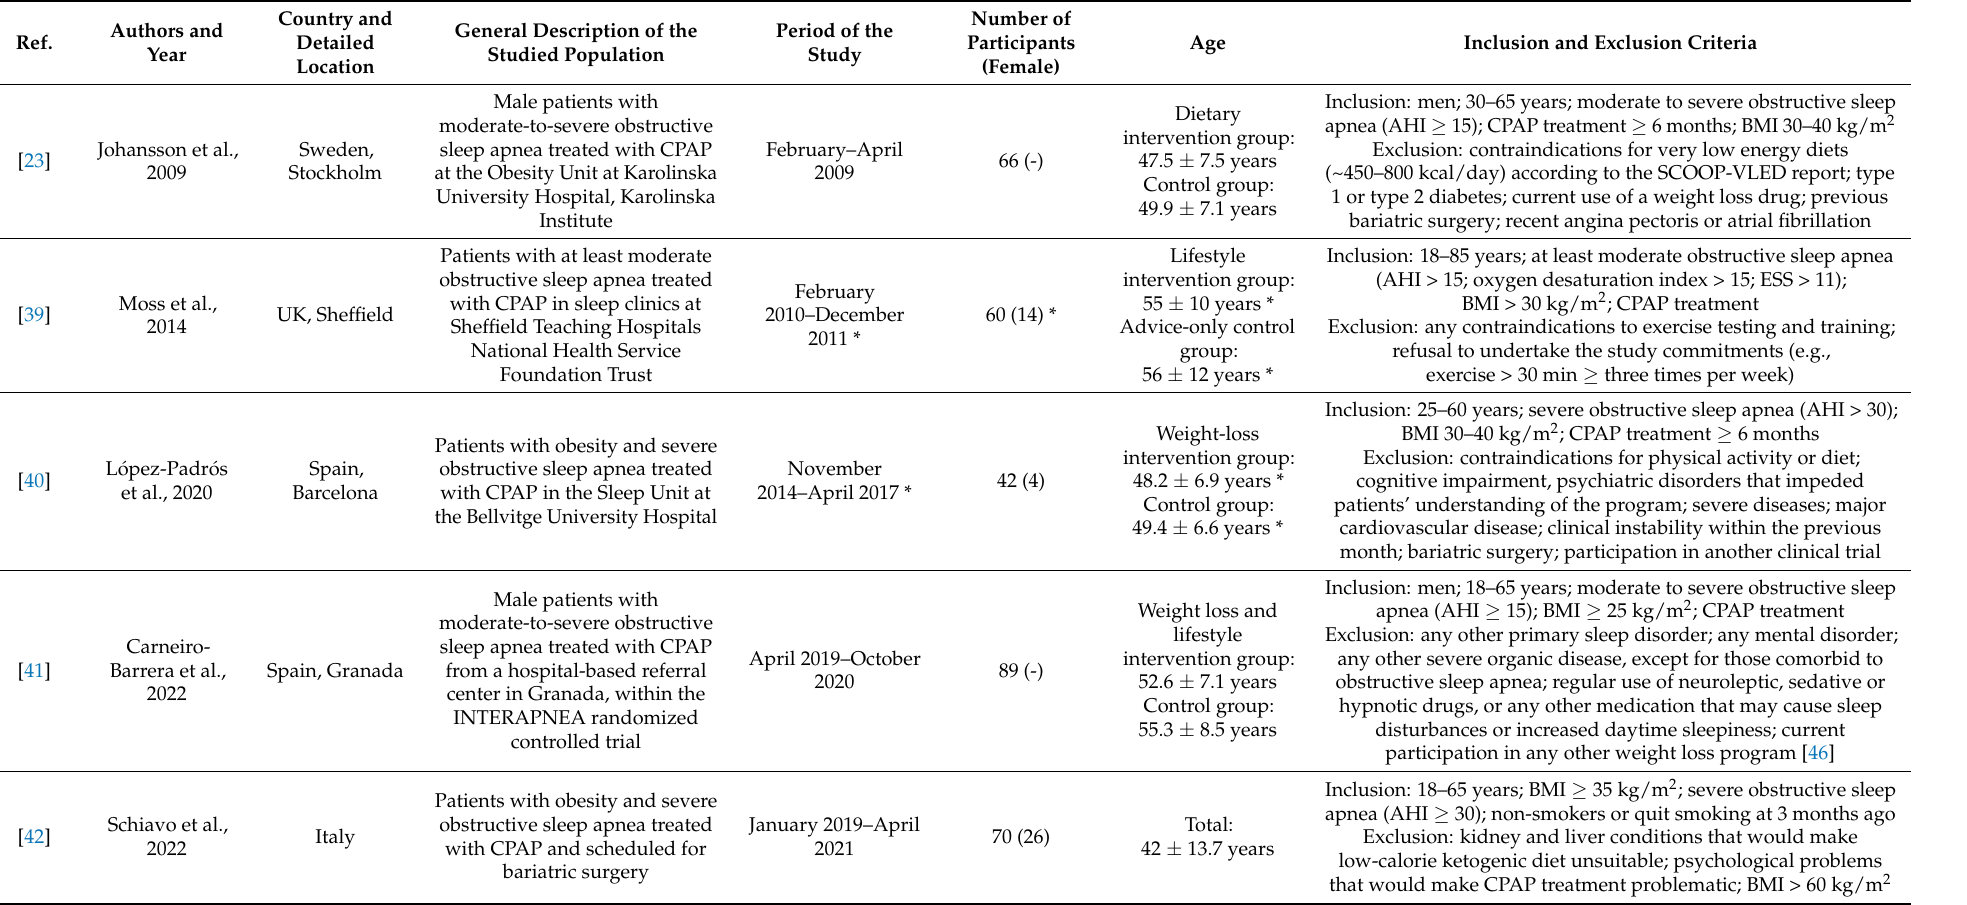
Table 3. General characteristics of randomized controlled trials included in this study and studied